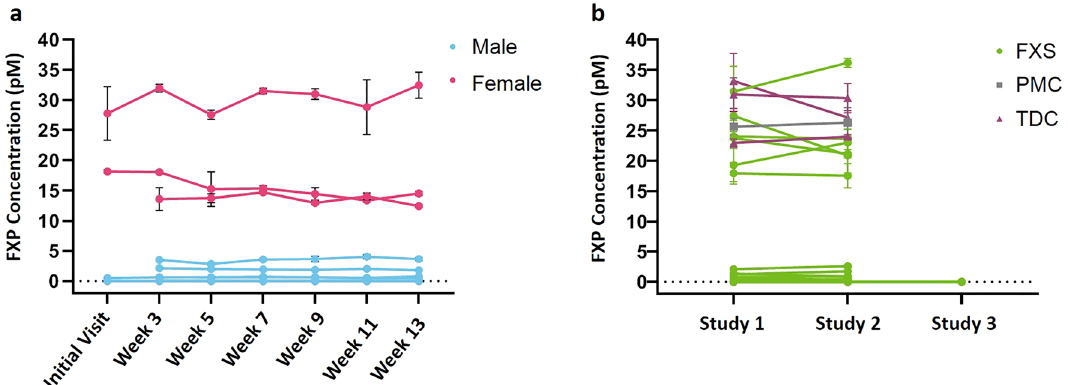
Figure 6. FXP concentrations are consistent over time. ( a ) Repeated bi-weekly FXP levels in 12 adults with FM FXS (9 males; 3 females) showed consistency over 13 weeks (ICC value 98.8), ( b ) Over longer intervals between FXP testing (mean 11 months; range 0.5–30 months), within subject FXP levels showed consistency (ICC value 97.6) in 25 persons (18 males, 7 females; age range 0.5–49.8 years) across all diagnostic categories. Note